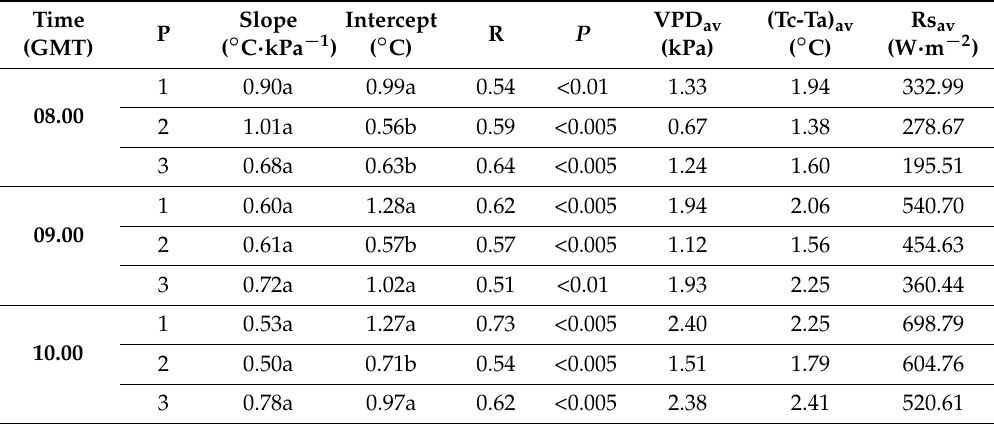
Table 3. Hourly correlations between Tc-Ta versus VPD to establish non-water stressed baselines (NSWBs) using cloudless days for different seasonal periods. Period 1 (P1, DOY 193 to 212), period 2 (P2, DOY 213 to 239), and period 3 (P3, DOY 240 to 257). GMT: Greenwich Mean Time. VPD: Vapor pressure deficit. Rs: Solar radiation. The suffix av indicate the average. Each value is obtained from hourly Tc-Ta and VPD average at a given hour of a given day of each period, using the Tc of the fully irrigated trees (TW-FI). Number of points for each regression was 19, 19, and 15 for P1, P2, and P3, respectively. Different letters within the same column indicate significant differences among Time (GMT), according to ANCOVA ( P <